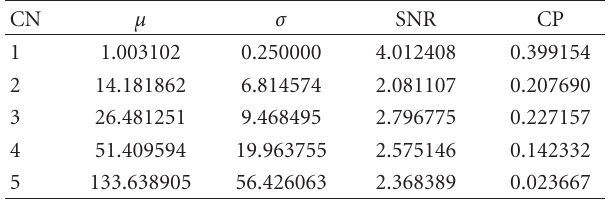
Table 4: Statistical information about the best class number for the simulated phantom data set, tumour 2.